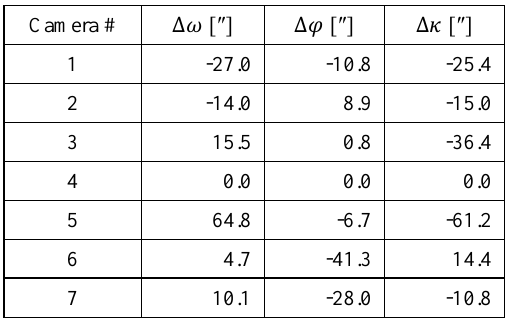
Table 12. Differences in the rotational components of the ROPs between the one-round minor calibration and the full major